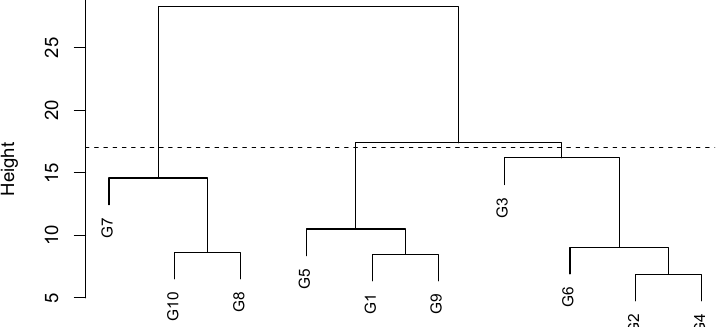
Figure 3. Dendrogram of physiological characteristics of 10 piquin pepper genotypes.